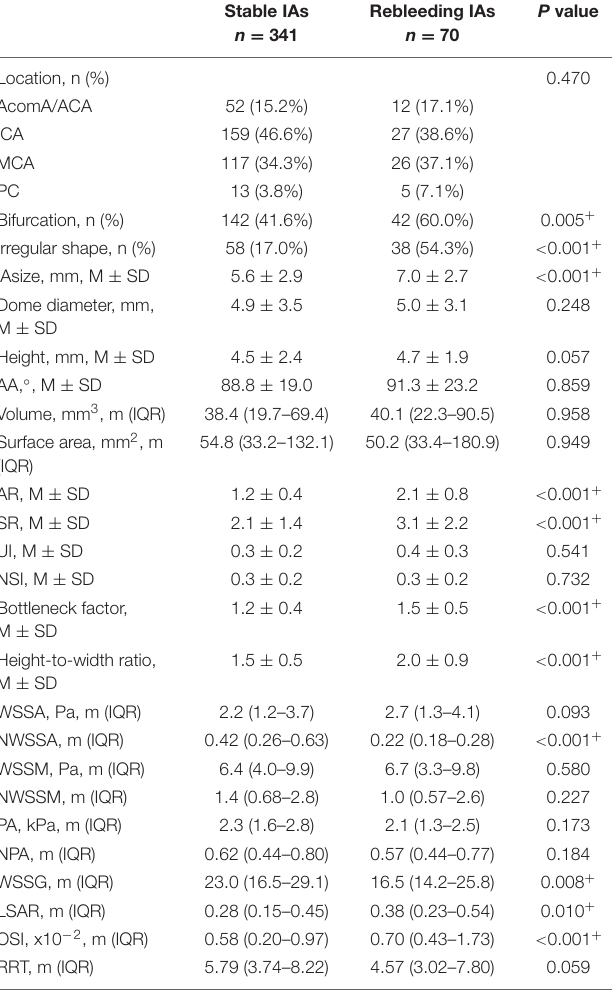
TABLE 3 | Multivariate Cox analysis for rebleeding before surgery in the primary cohort.